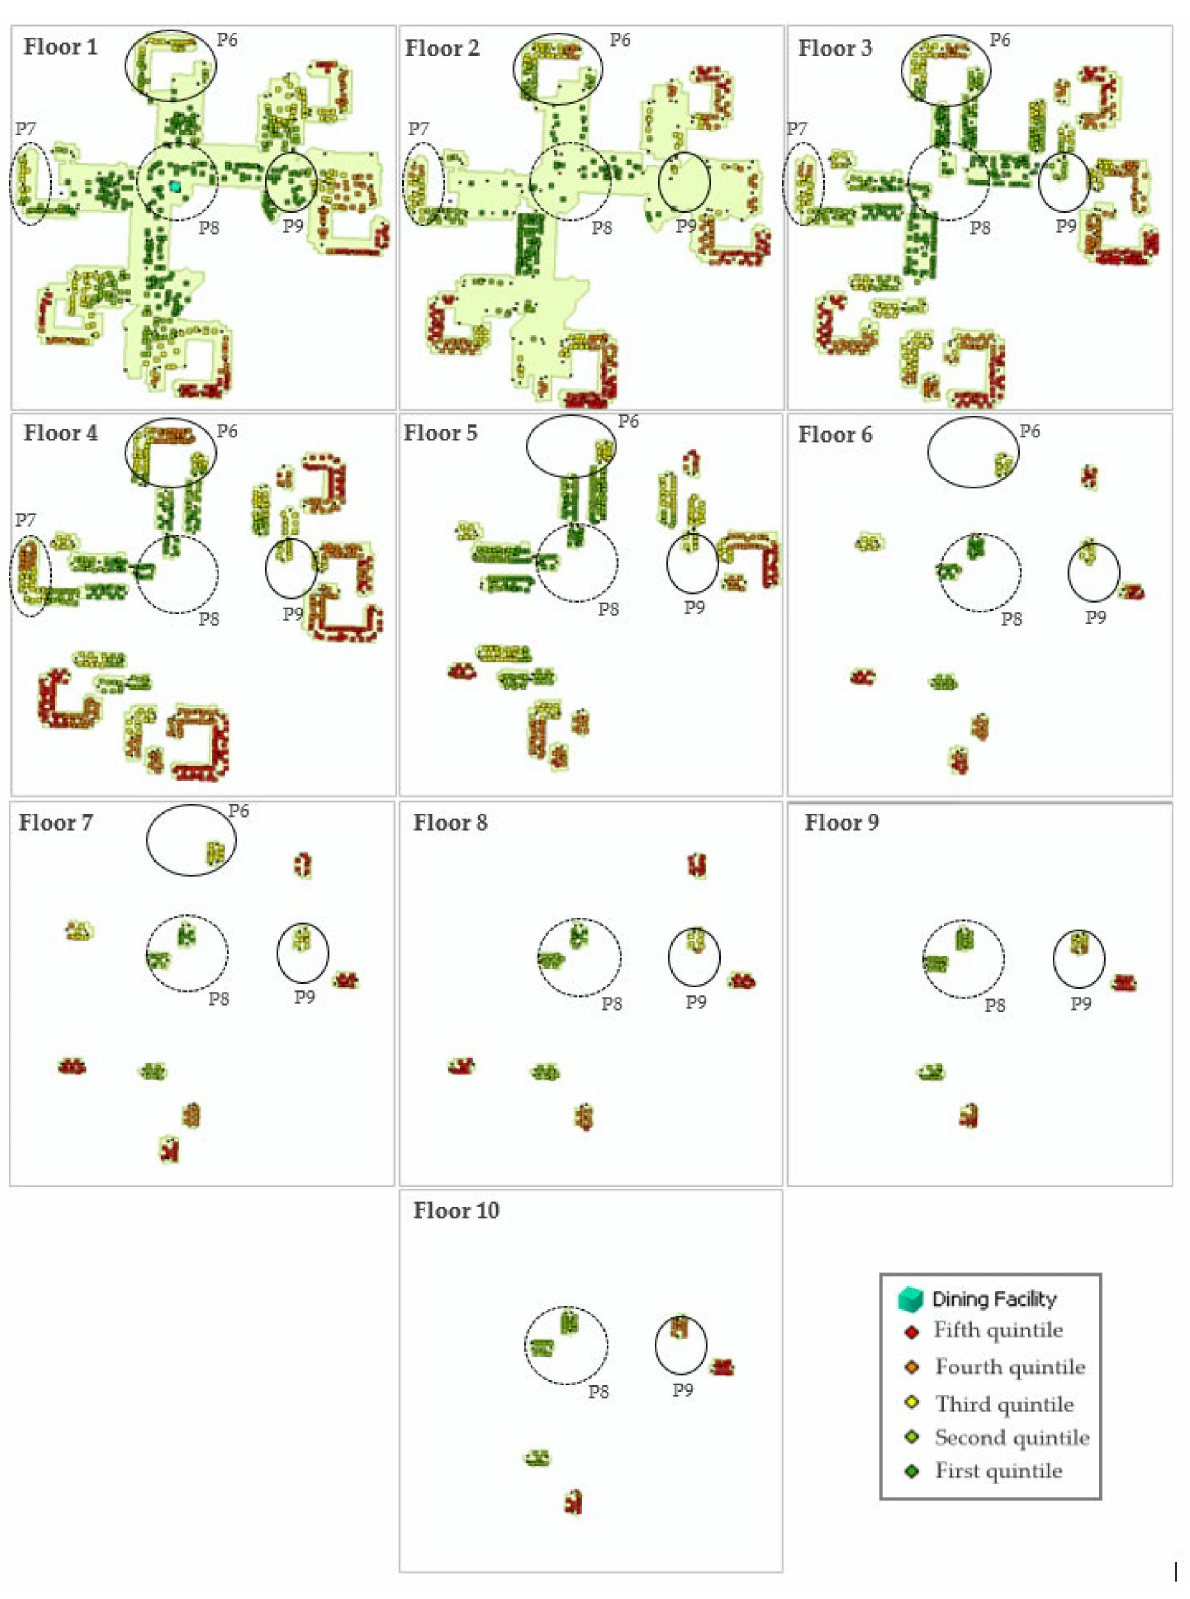
Figure 20. Metric accessibility to dining facility 3 on different floors: classification in